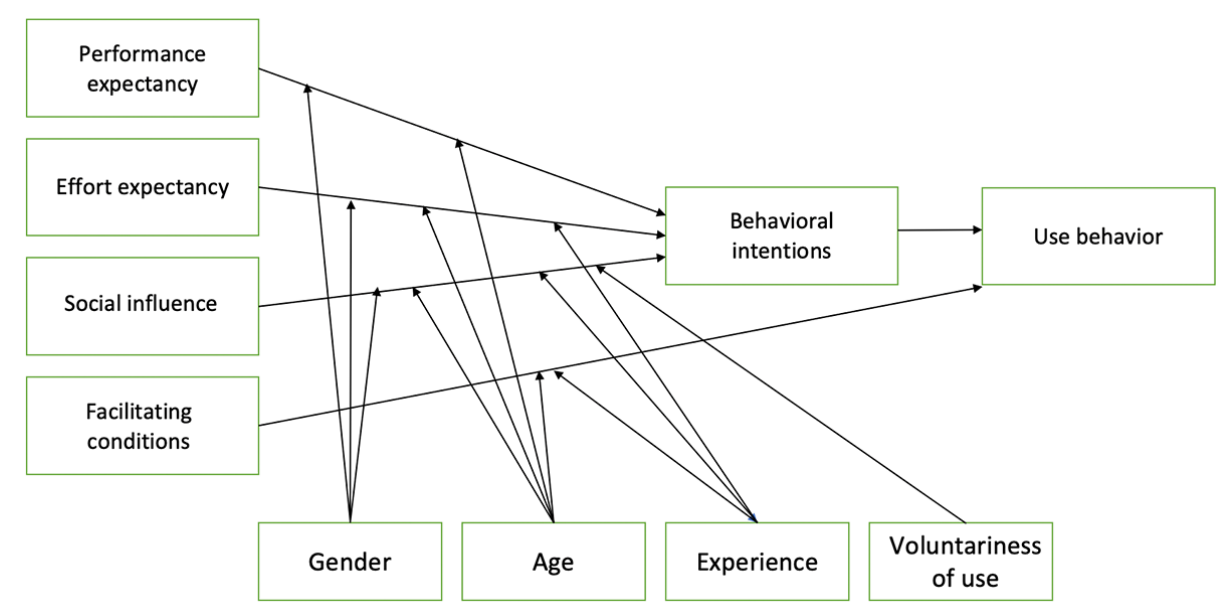
Figure 1. The Unified Theory of Acceptance and Use of Technology